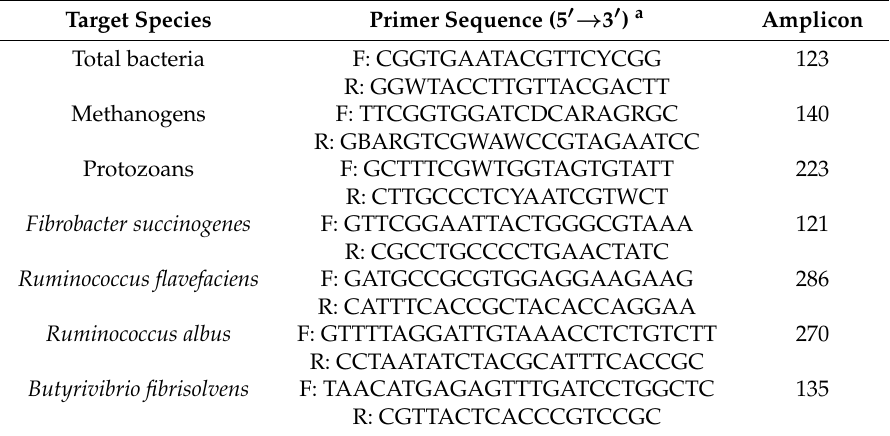
Table 2. Primers for qPCR